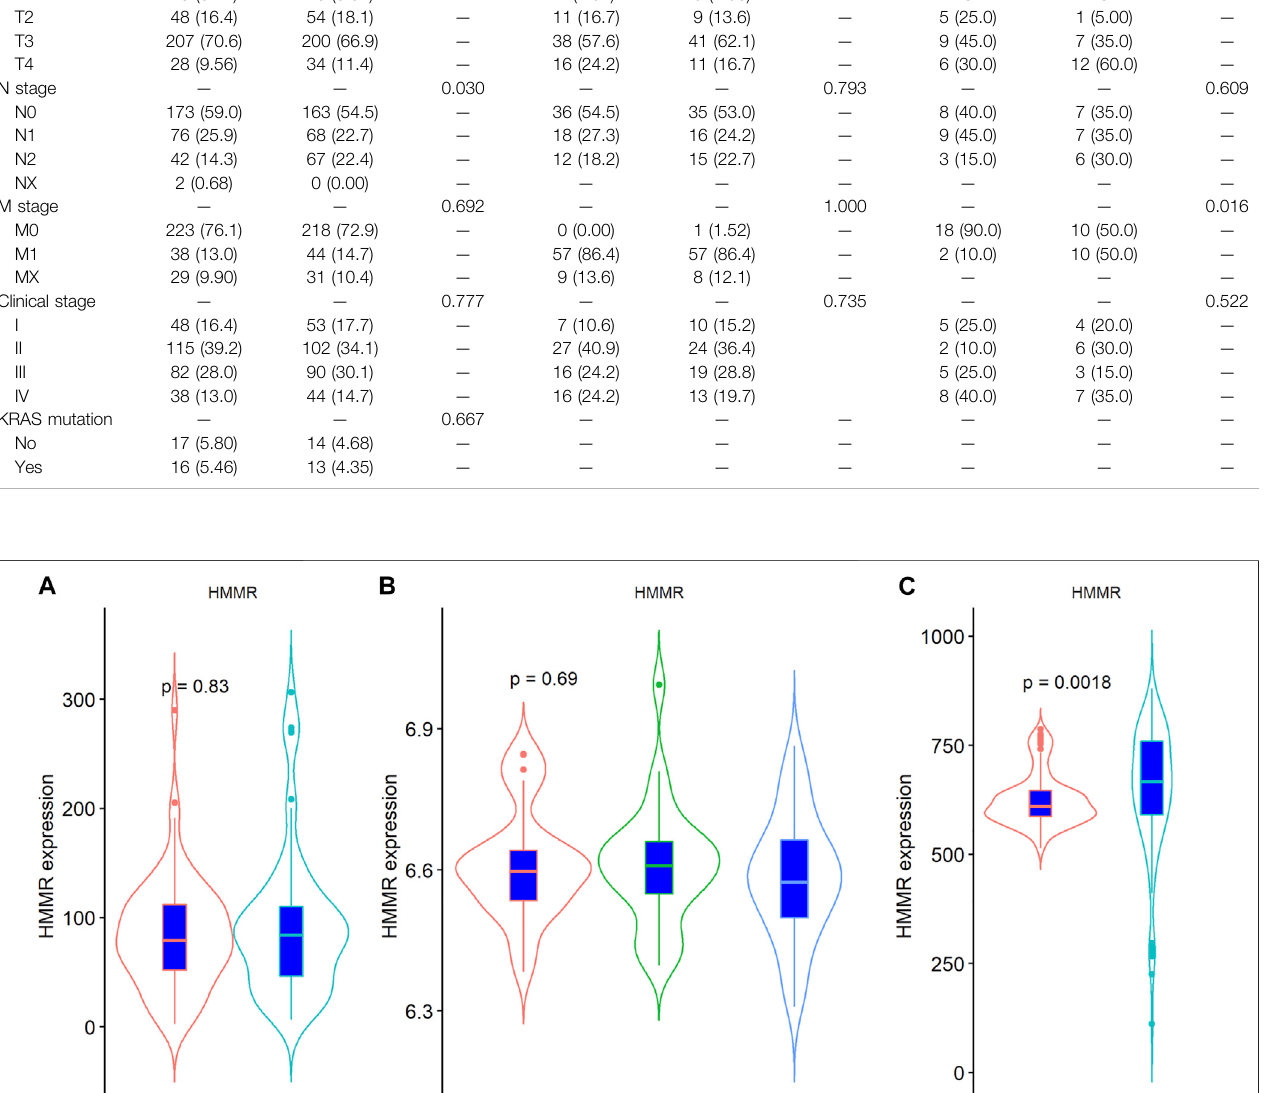
Frontiers in Molecular Biosciences |